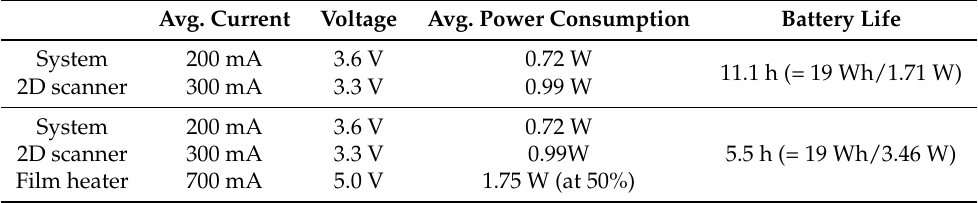
Table 1. Power consumption of the existing system: with film heater off (top) and on